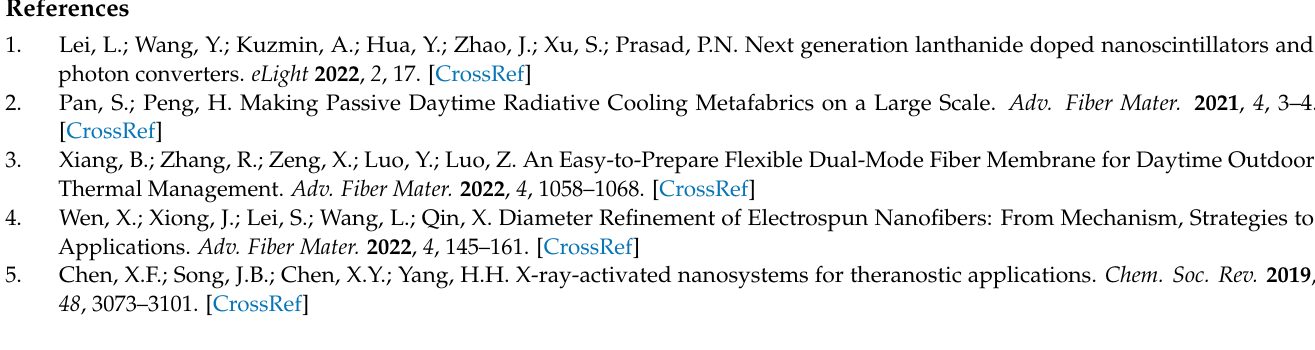
4 Lu 3 F 17 : 30Tb10Ce and CsI